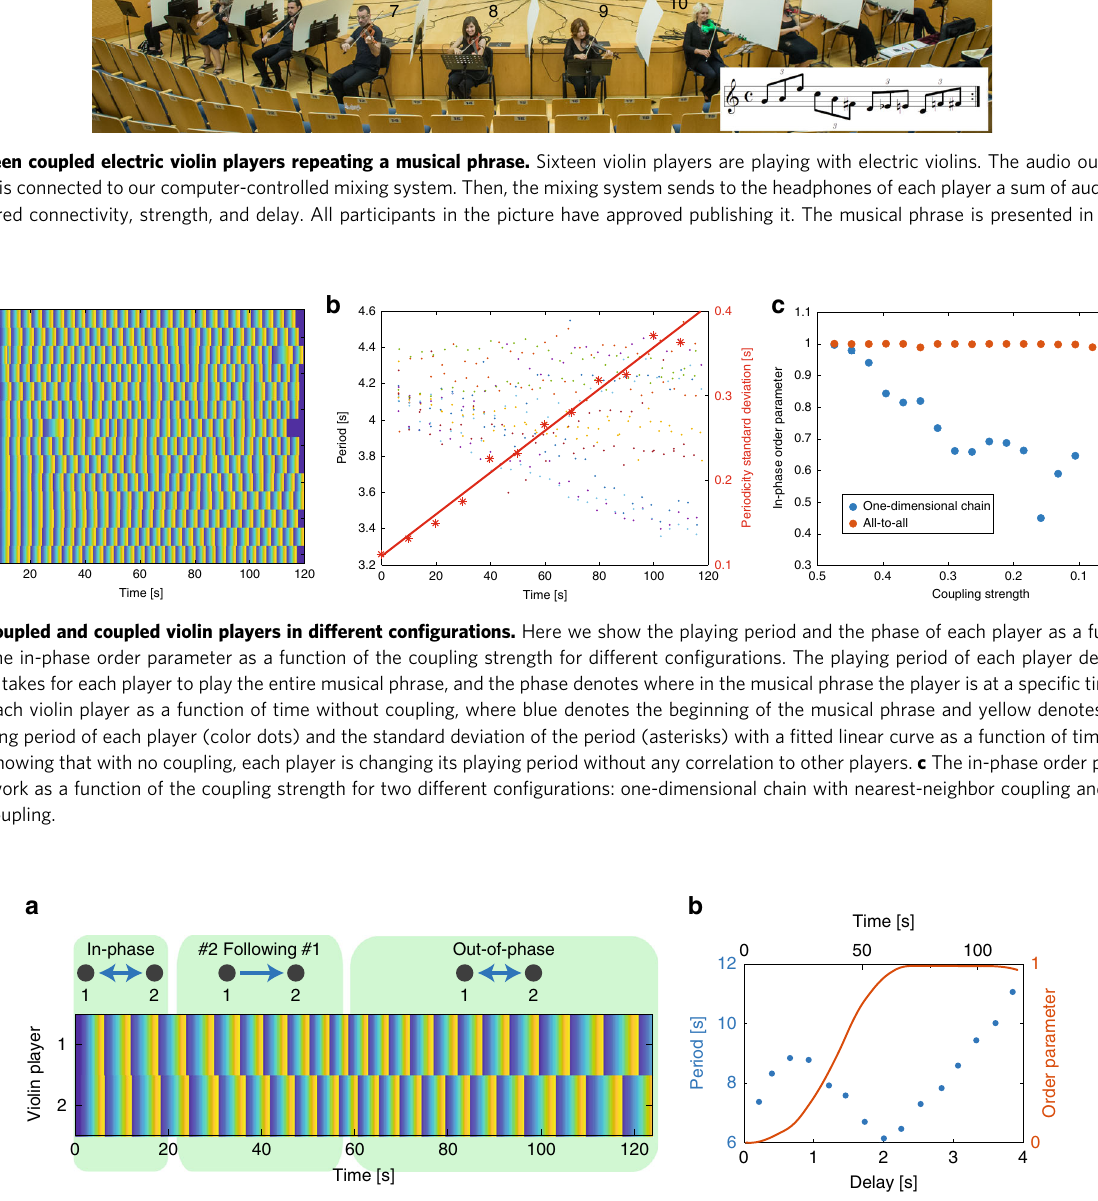
Fig. 3 Two coupled violin players with a delay between them. a The phase of each player along the musical phrase as a function of time in one representative measurement. When the delay is zero, the two players are following each other in-phase indicated by a double-head arrow between them. When the delay increases, only one of the players can follow the other, which is indicated by a single-head arrow. When the delay reaches half of the playing period time, the two players can follow each other again in an out-of-phase state of synchronization, indicated by a double-head arrow. b The mean playing period of all the players and the out-of-phase order parameter of the network as a function of the delay and time, averaged over a moving